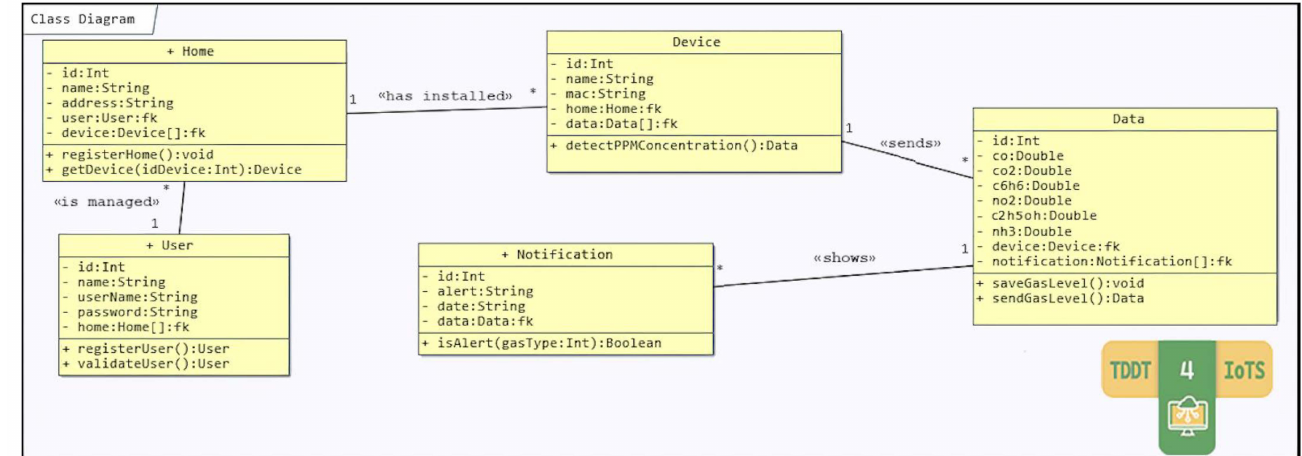
Figure 5. IdeAir refined class